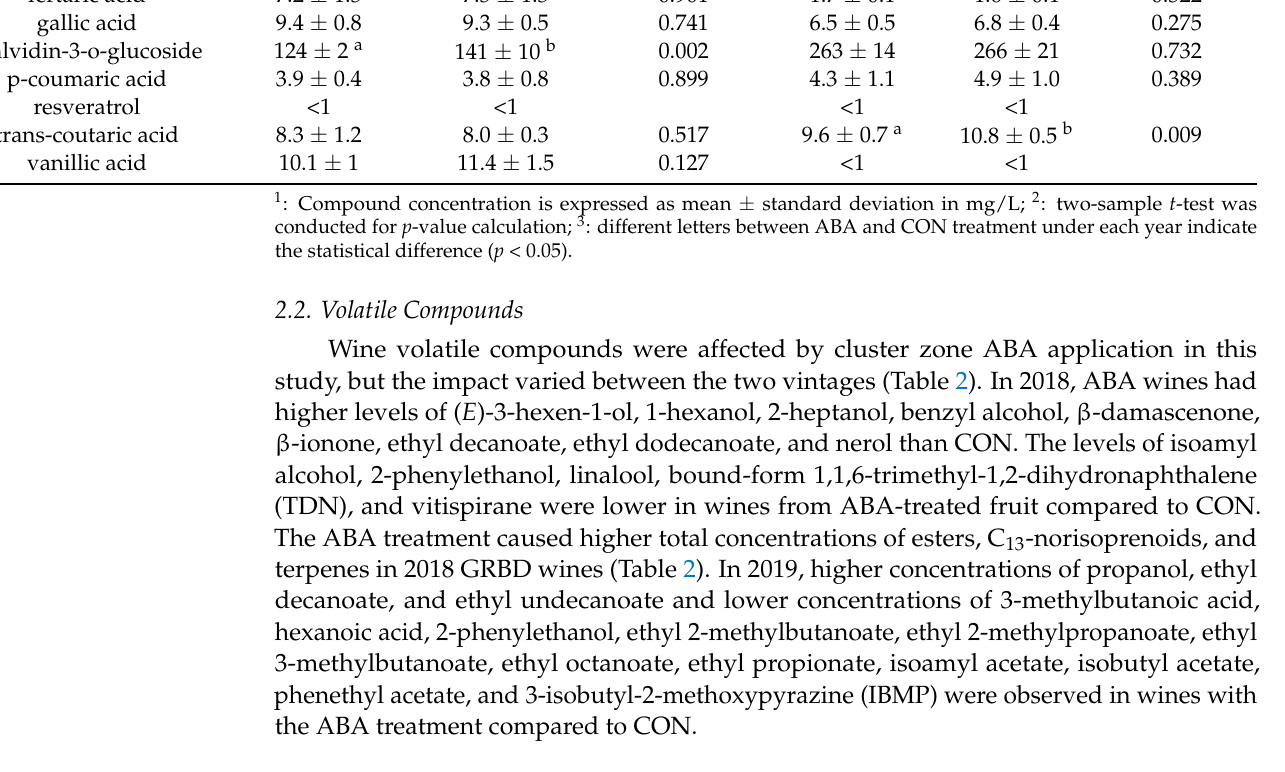
Table 2. Volatile compounds in wines produced from GRBV-positive Pinot noir vines under exoge- nous abscisic acid application (ABA) and no abscisic acid control (CON) during two